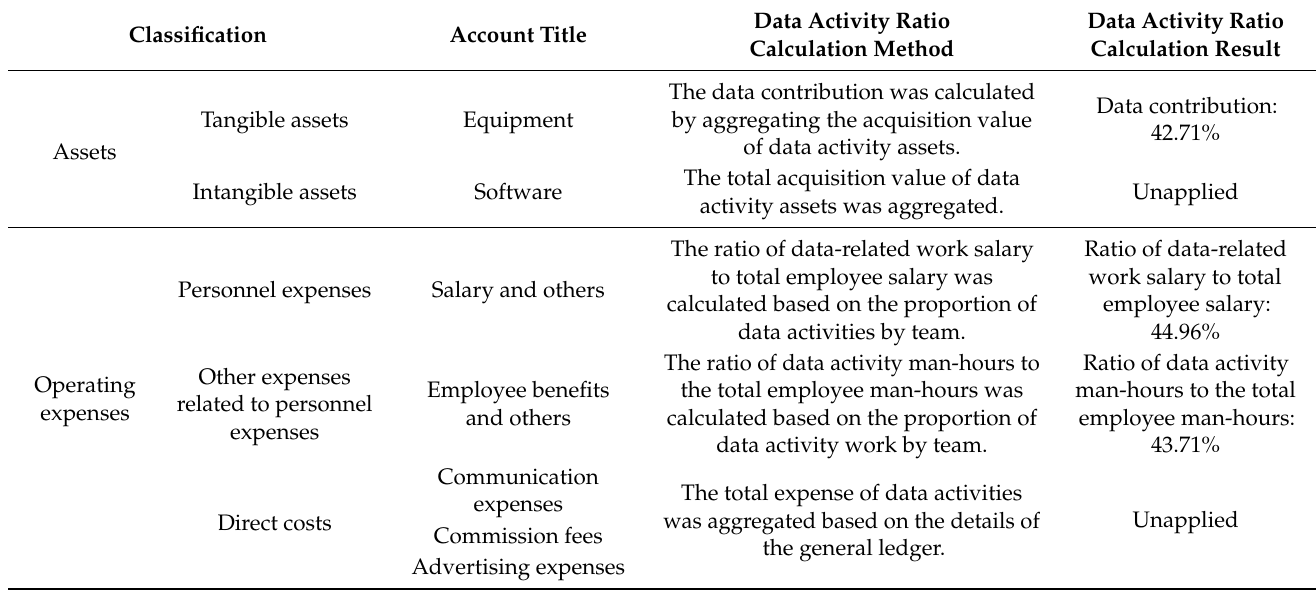
Table 6. Data activity ratio calculation method and result by asset and operating